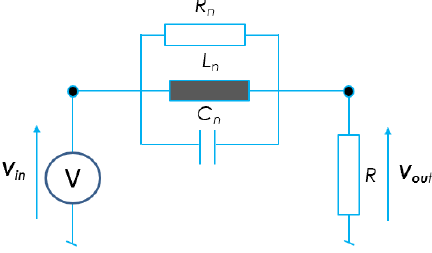
FIGURE 3. RLCP network-based BP NGD passive cell under